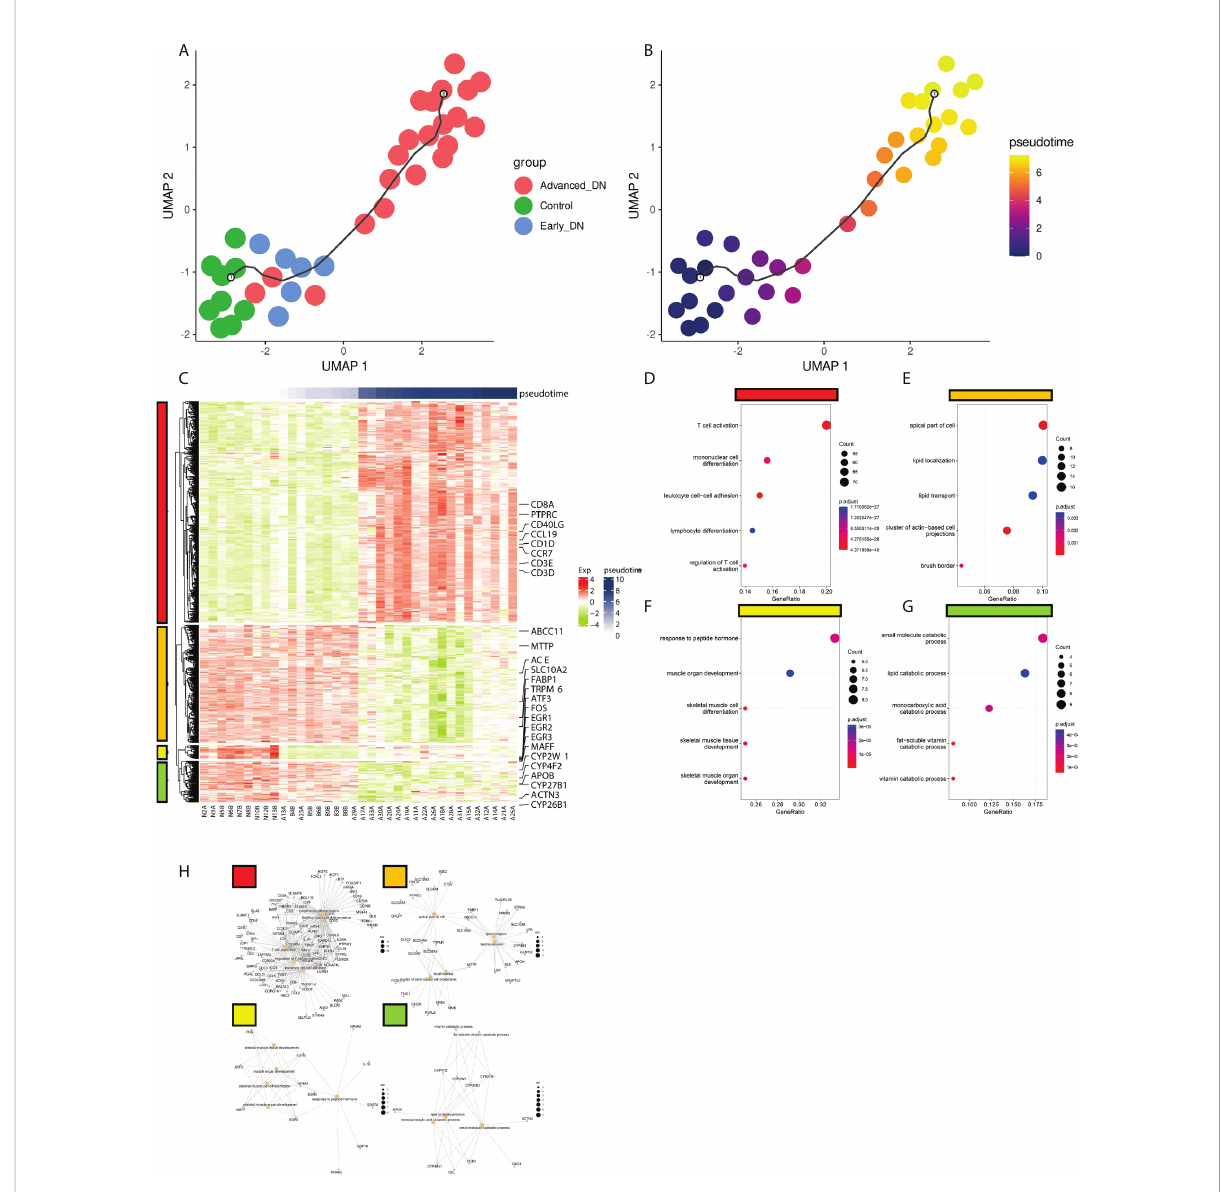
FIGURE 5 Pseudo-time analysis of DN occurrence and development. (A) Distribution of DN samples on the quasi-series plot. (B) Disease progression in DN patients deepens with Pseudotime curve. (C) Gene expression modules driving DN progression. There were four modules here (red, orange, yellow, green). (D,E,F,G) The functional enrichment analysis results of the four gene expression modules (KEGG genesets). (H) The gene enrichment network information map of the four gene expression